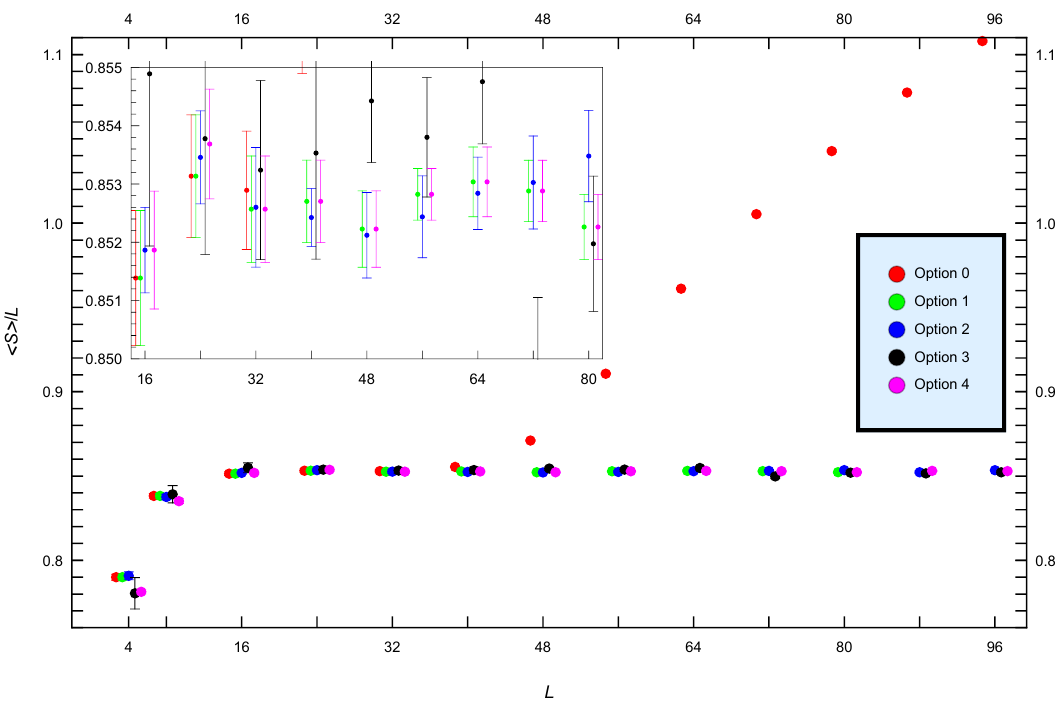
Figure 7 . The action density for the di(cid:11)erent options that can be used for resolving the numerical stability of contour 4. The various options are colour marked. Ignoring the problem (red) leads to an erroneous increase of the action density beyond L ’ 40. All other options lead to similar and consistent results. As can be seen in the inset, in which the y coordinate is magni(cid:12)ed, for L > L c (cid:17) 24 option 4 (using the approximate expression for the Jacobian) produces similar results to the ones obtained by option 1 (using the exact algorithm). In fact, the two options produce in this range identical results, within our working